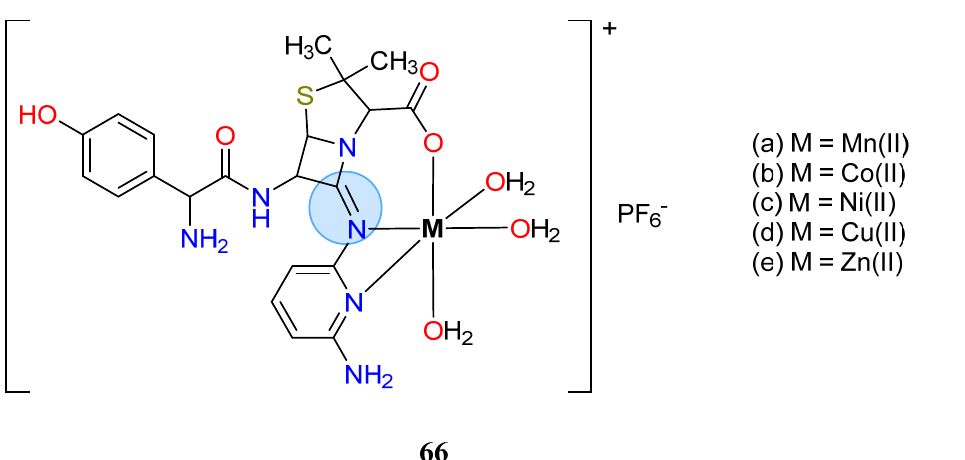
Figure 30. Metal(II) complexes with a Schiff base ligand derived from amoxicillin studied for antibacterial activity.